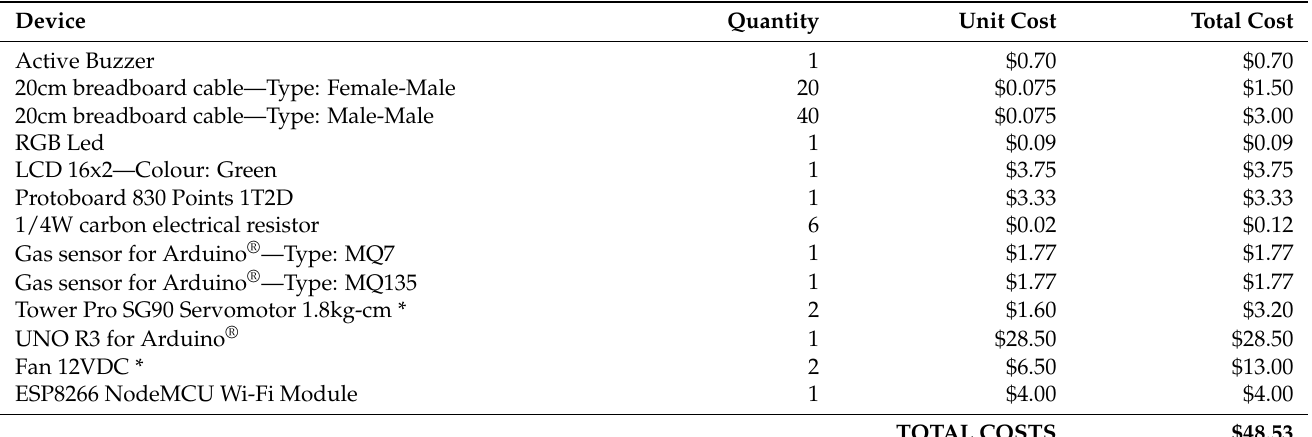
Table 4. Cost of the hardware components required to implement the IdeAir